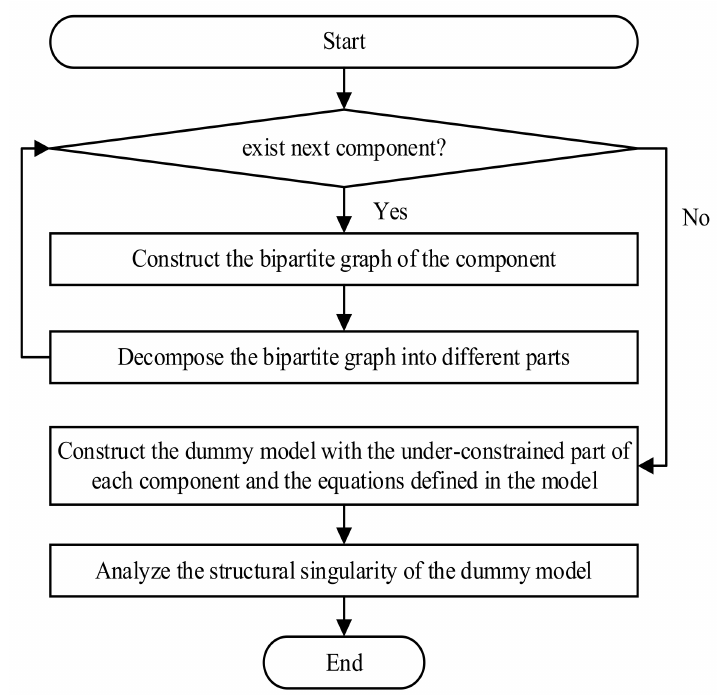
Figure 4. Process of hierarchical structural